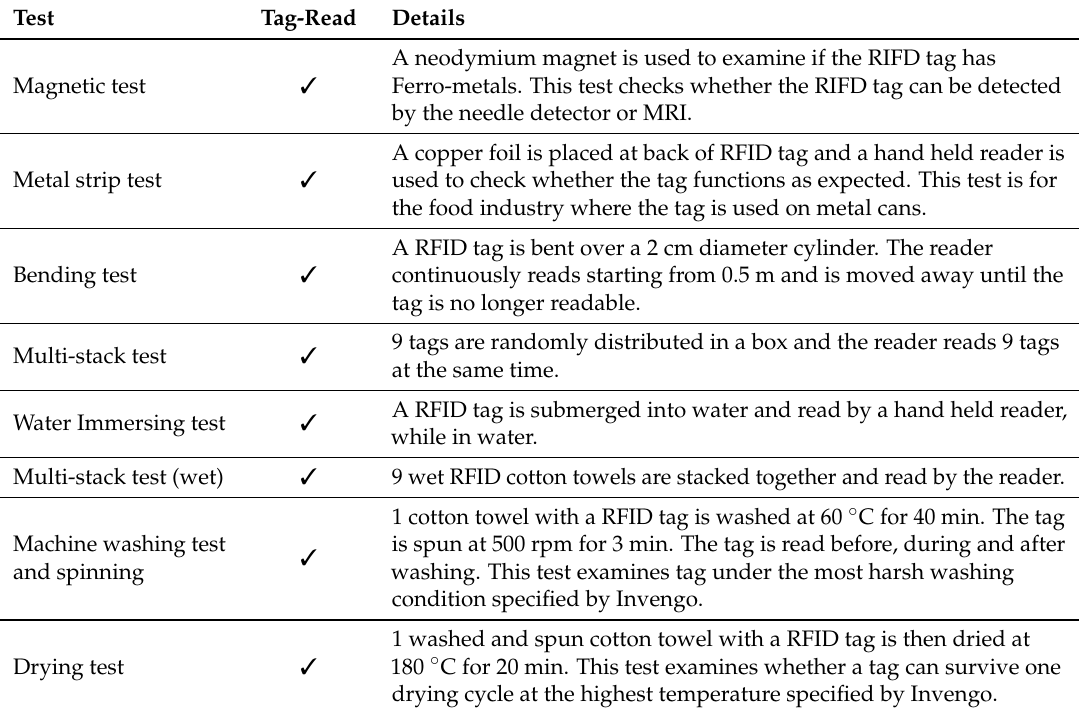
Table 3. Test procedure of the textile-integrated RFID